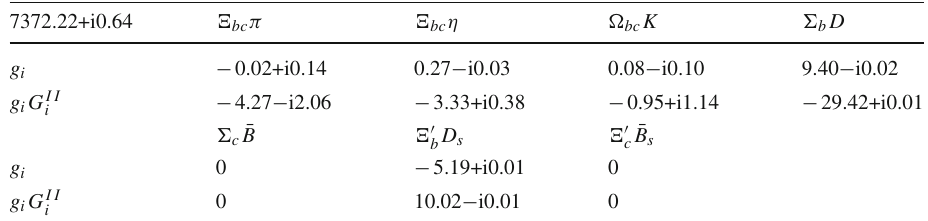
to various channels and g i G II in MeV with q max = 650MeV